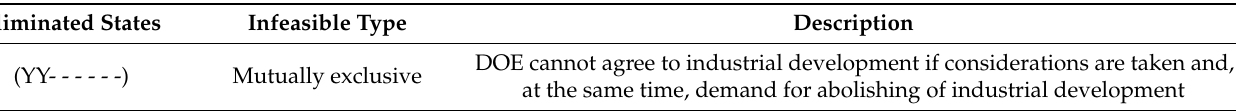
Table 2. Infeasible states in the industrial land development of Markazi